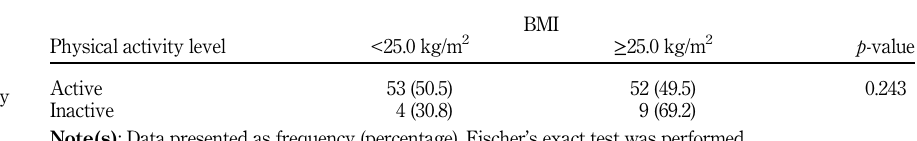
Table 3. Prevalence of overweight/ obesity based on physical activity levels